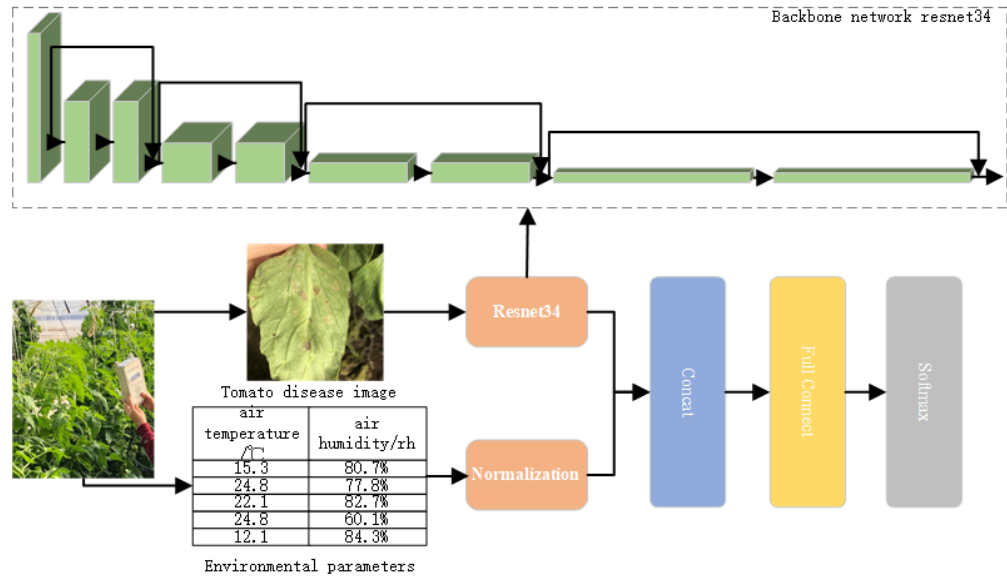
Figure 6. Tomato Multimodal Data Fusion Recognition Multi-ResNet34